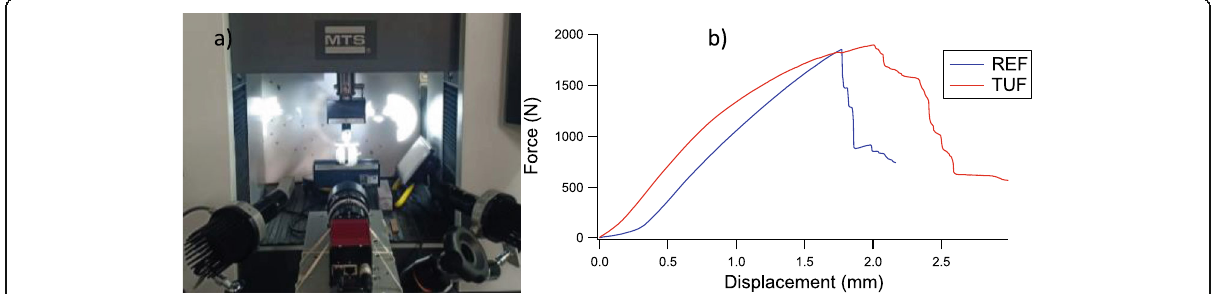
Fig. 6 a DIC carried out on short beam. b Load-Displacement curve of flexion for REF and TUF green biocomposite